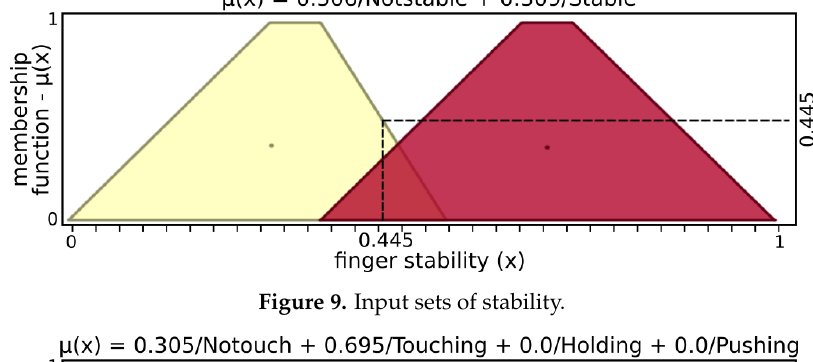
Figure 9. Input sets of stability.